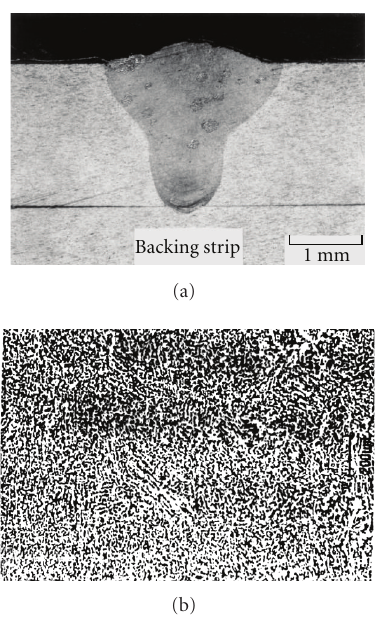
Figure 10: (a) Cross section of AA5083 butt welded joint produced using backing strip with P = 4kW, S = 6m/min, Dd = − 1 . 5 mm, (b) Optical micrograph of its weld metal.